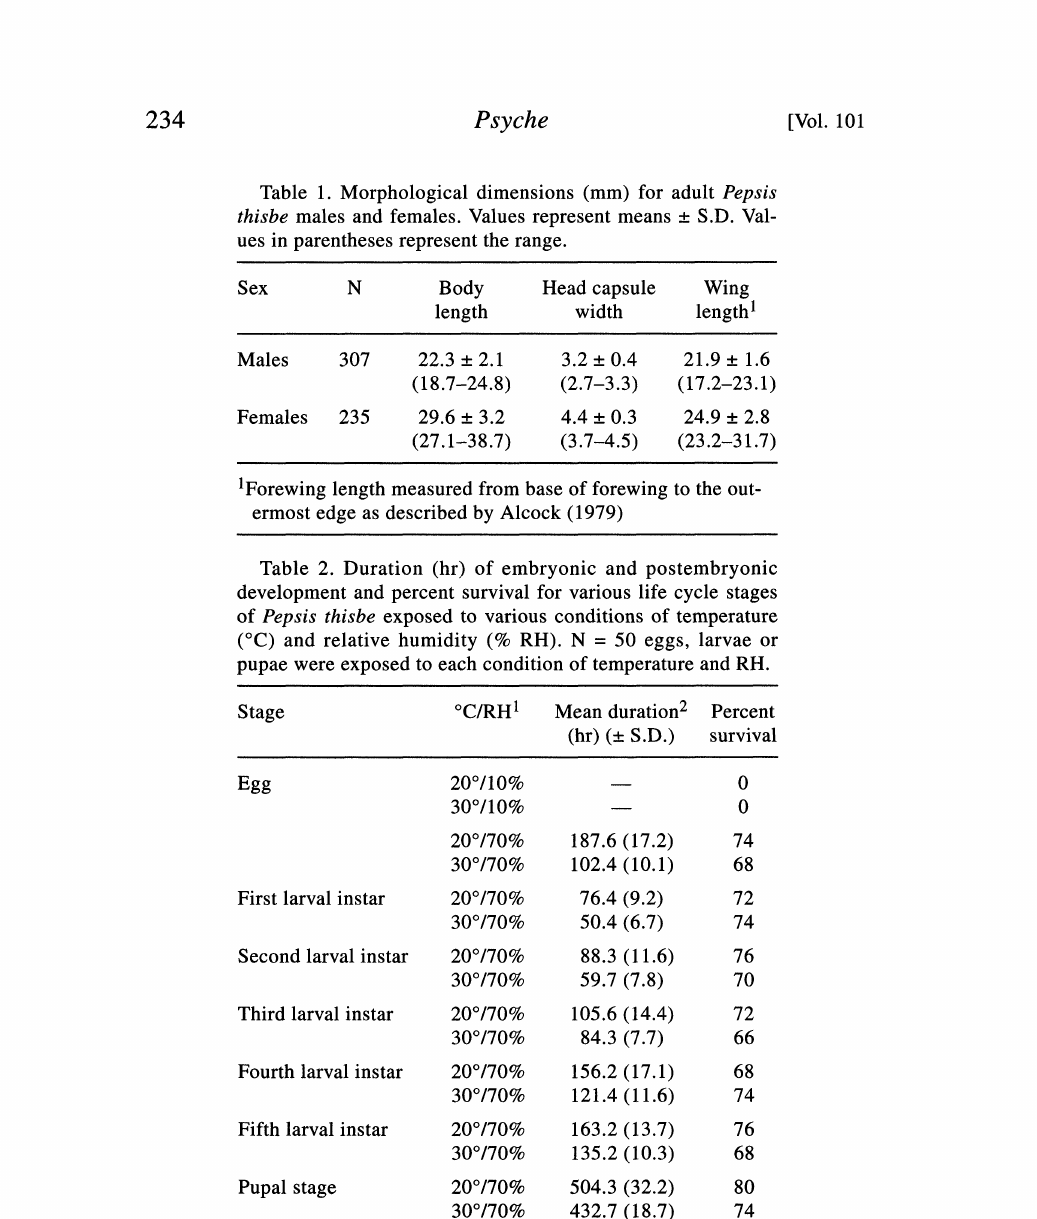
Table 1. Morphological dimensions (mm) for adult Pepsis thisbe males and females. Values represent means _+ S.D. Val- ues in parentheses represent the range.